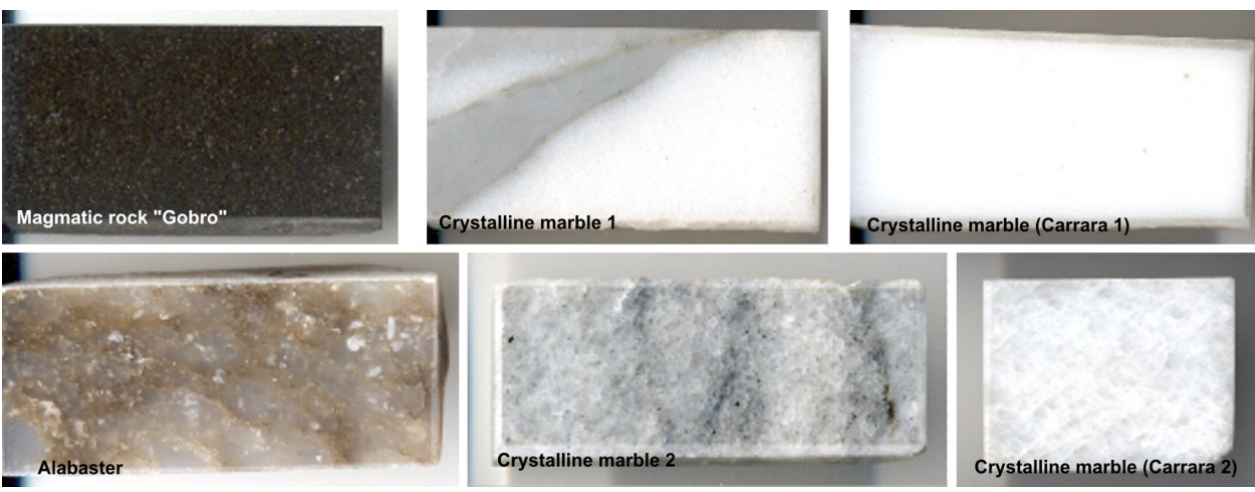
Figure 50. Photographs of stone samples before determination of laser ablation damage